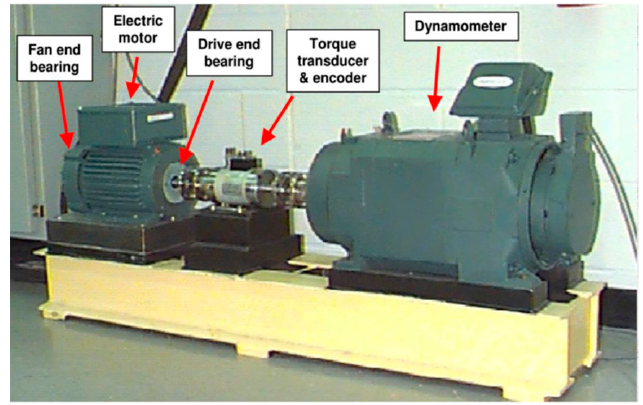
Figure 2. The CWRU bearing test rig [32,33].